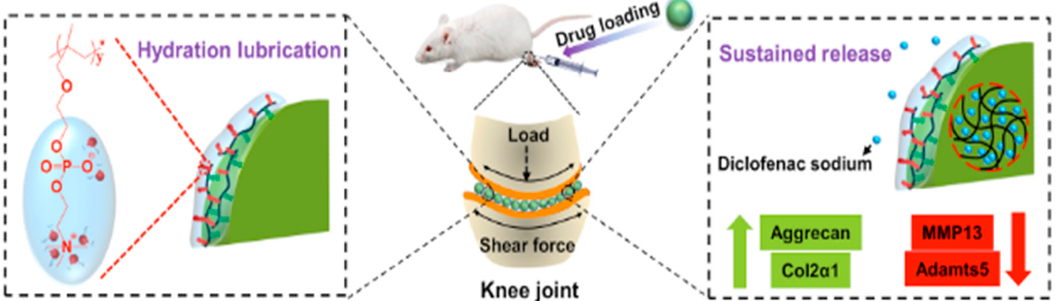
Figure 3. Schematic representation of the intra-articular injection of drug-loaded lubricant micro- gels for the treatment of osteoarthritis. Adapted from Han et al. [69]; licensed under CC BY 4.0 (open